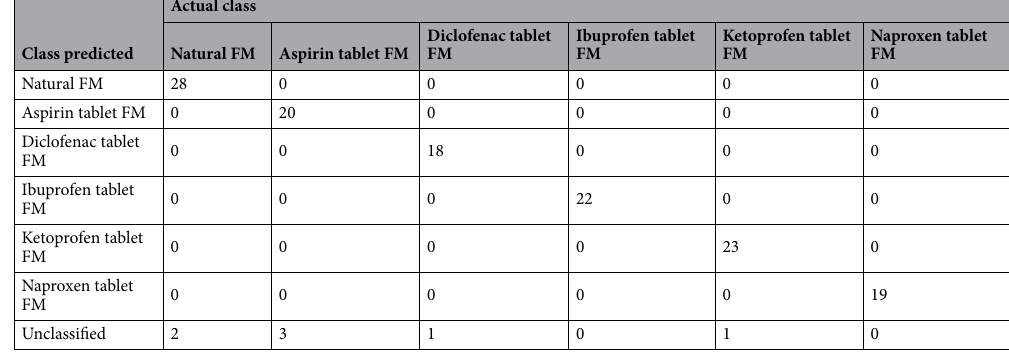
Table 2. A confusion matrix for individual spectra obtained for the external validation of the PLS-DA model based on five latent variables using the regions selected by the GA method.